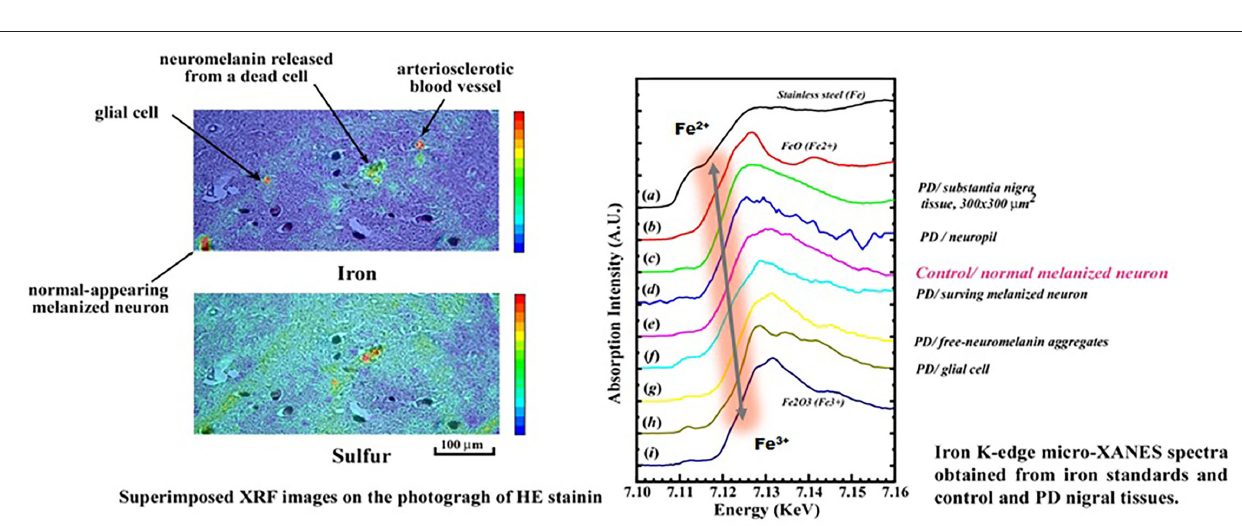
FIGURE 8 | Chemical shifts of Fe from Fe 2 + to Fe 3 + in the neuromelanin complex during the Oxidative process of nigral cell degeneration in Parkinson’s disease